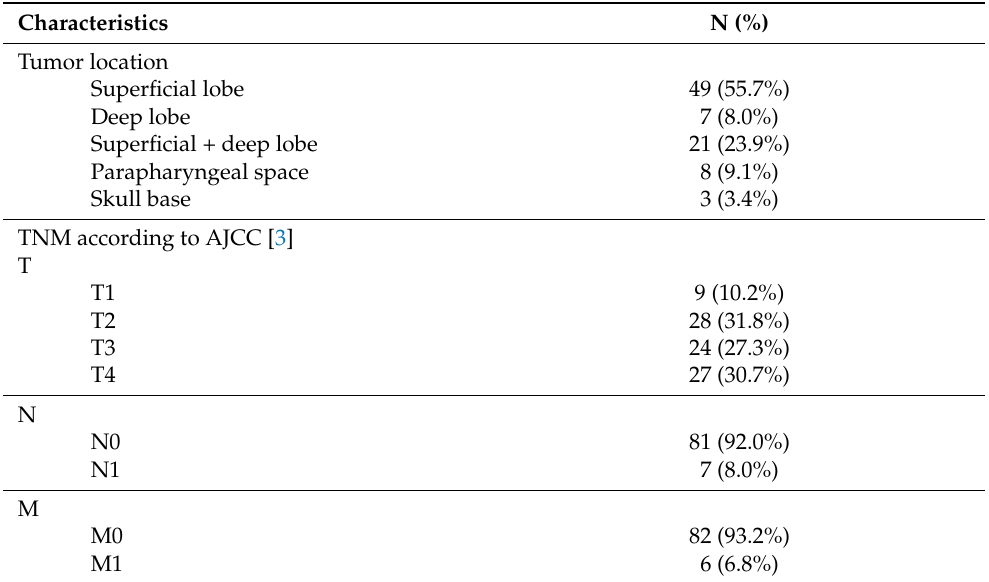
Table 2. Tumor location and TNM according to AJCC [3] of the parotid gland sarcomas included in this